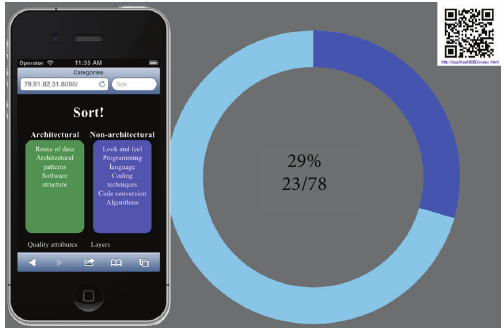
Figure 3: The Categories application (the student view is shown to the